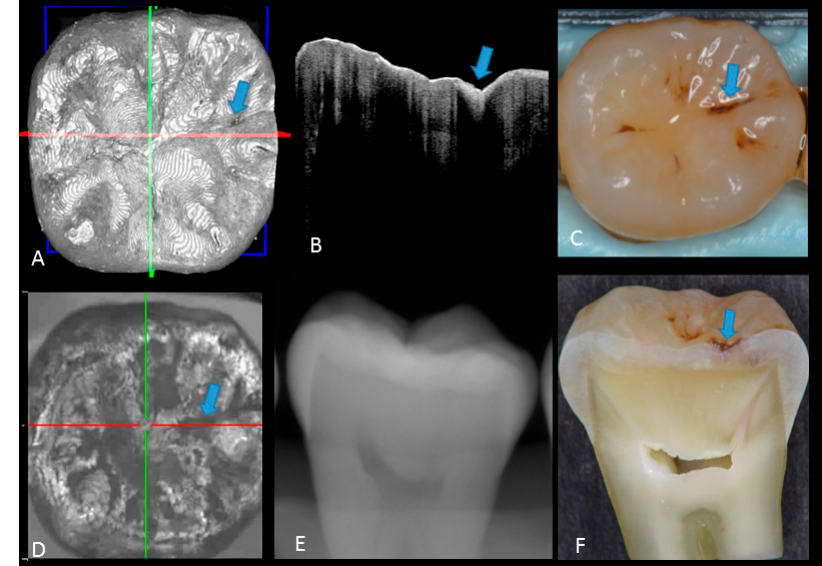
Figure 3. Enamel caries: ( A ) 3D OCT image; ( B ) cross-sectional OCT image along the red line in (A). Arrow shows a wedge-shaped area with increased scattering approximately half the thickness of the enamel, indicating demineralization with no surface breakdown; ( C ) photographic presentation of occlusal enamel with stained fissure (arrow); ( D ) OCT en face intensity projection; ( E ) radiograph showed no visible lesion; ( F ) cross-section view with shallow enamel dye penetration confirming demineralization without surface breakdown (score 1). The dynamic slicing 3D video is presented in Supplementary Materials: Video 2.